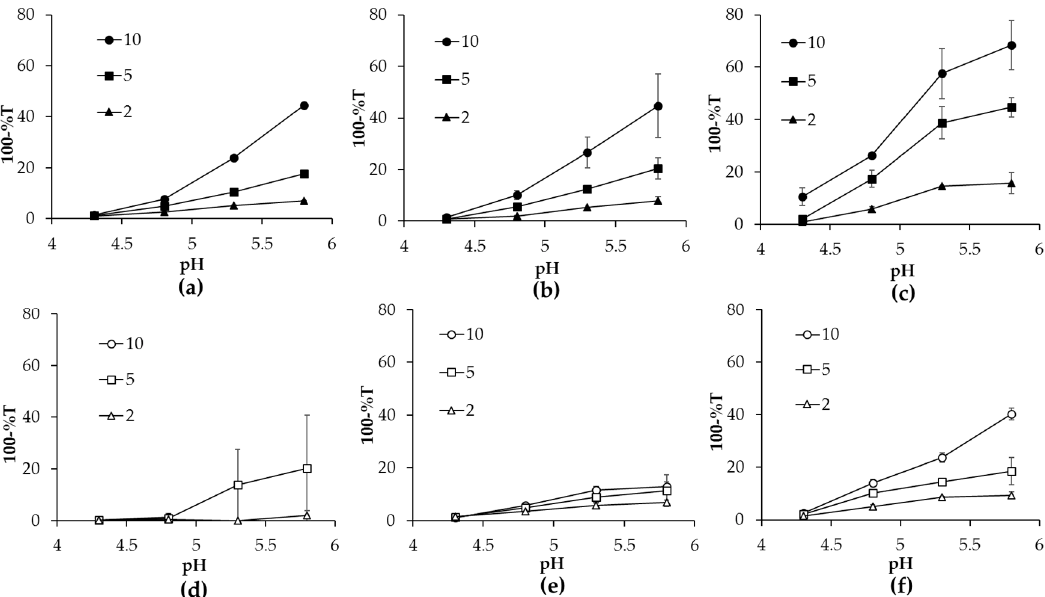
Figure 1. Effect of pH on turbidity of heated α -lac complexes at different r -values for mixtures with ( a ) CH 113 , ( b ) CH 76 , ( c ) CH 8.9 , ( d ) CH 113 PEG, ( e ) CH 76 PEG, and ( f ) CH 8.9 PEG. Note that datapoints are not shown for α -lac/CH 113 PEG for r = 10 at pH 5.3 and 5.8 due to formation of precipitates.